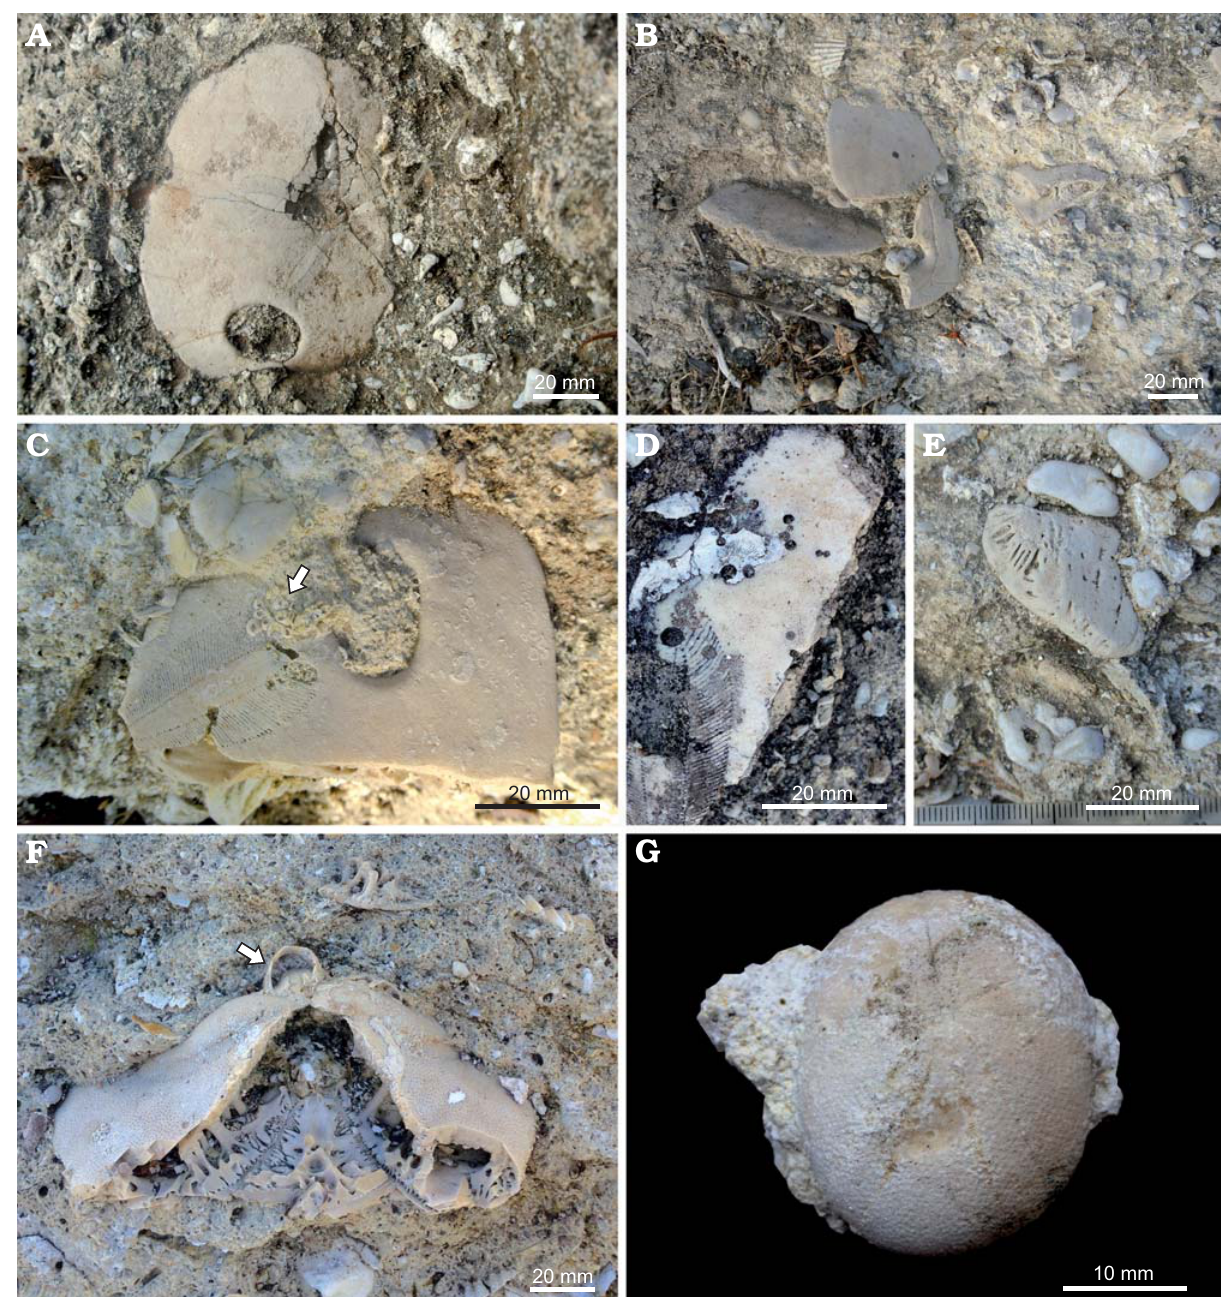
Fig. 4. Bancali Assemblage 1 (A–E) and Bancali Assemblage 2 (F, G); early Miocene, Bancali, Sardinia, Italy. A . Amphiope sp. showing collapse of the central area of the test. B . Chaotically oriented test fragments of Amphiope sp. C . Encrustation by barnacles (arrow) on Amphiope sp. remains. D . Circular holes on Amphiope sp. fragment. E . Highly abraded fragment of Amphiope sp. F . Clypeaster ( C. intermedius morphotype) encrusted by barnacles (arrow). G . Koehleraster sp. (MDLCA